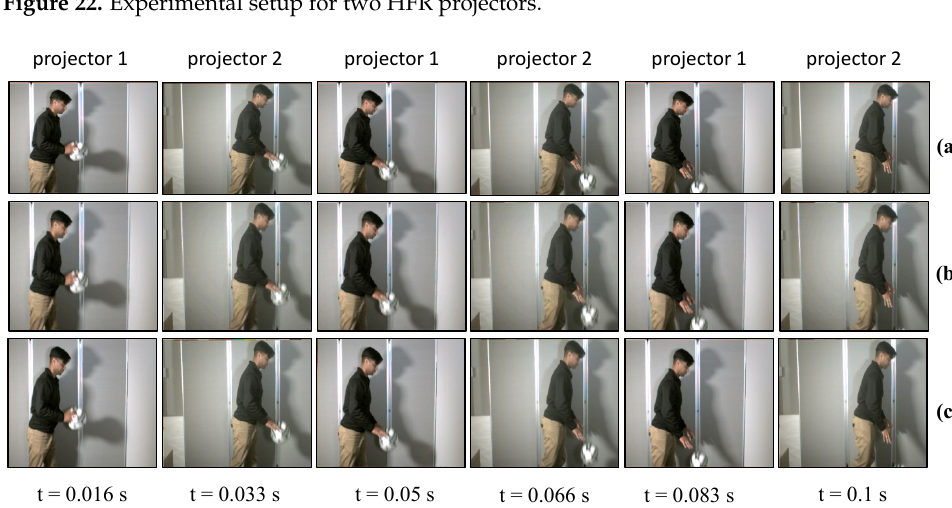
Figure 23. Reconstructed USB camera input image sequence: ( a ) 640 × 480 input image, ( b ) 510 × 459 binary-code image without background subtraction, and ( c ) 510 × 459 binary-code image with background